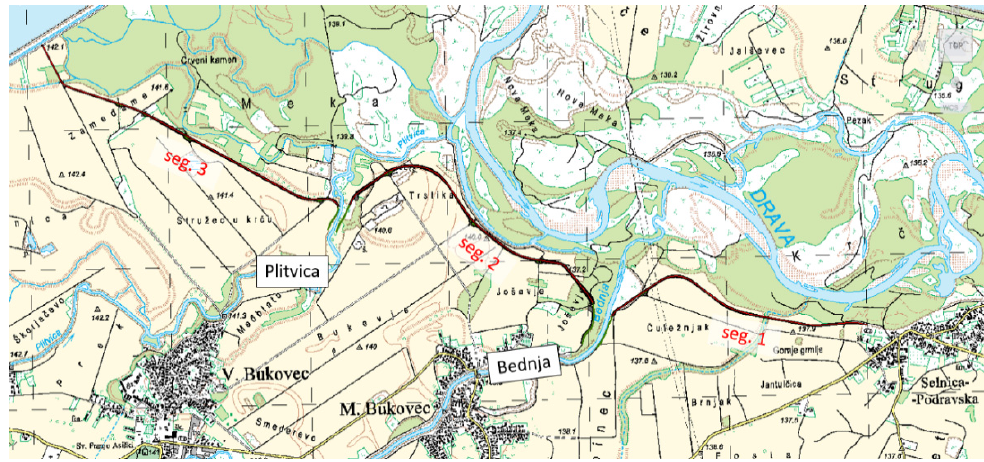
Figure 3. An overall layout of the Selnica–Dubovica levee with its distinctive